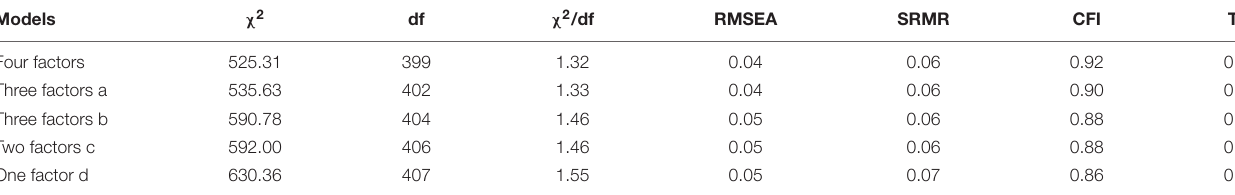
TABLE 3 | Confirmatory factor analysis